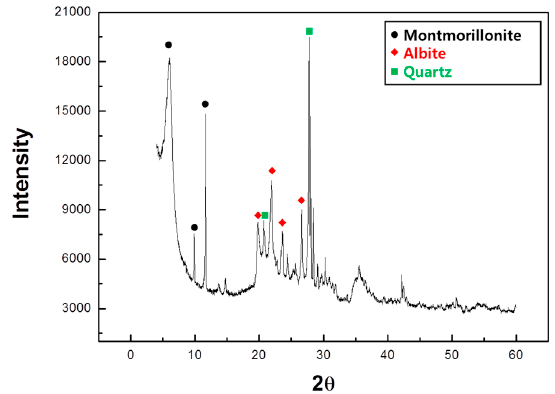
ff raction (XRD) results of for acid clay. Materials 2019 , 11 , x FOR PEER REVIEW Figure 2. X-ray powder diffraction (XRD) results of for acid clay. Figure 2. X-ray powder di Figure 2. X-ray powder diffraction (XRD) results of for acid clay.